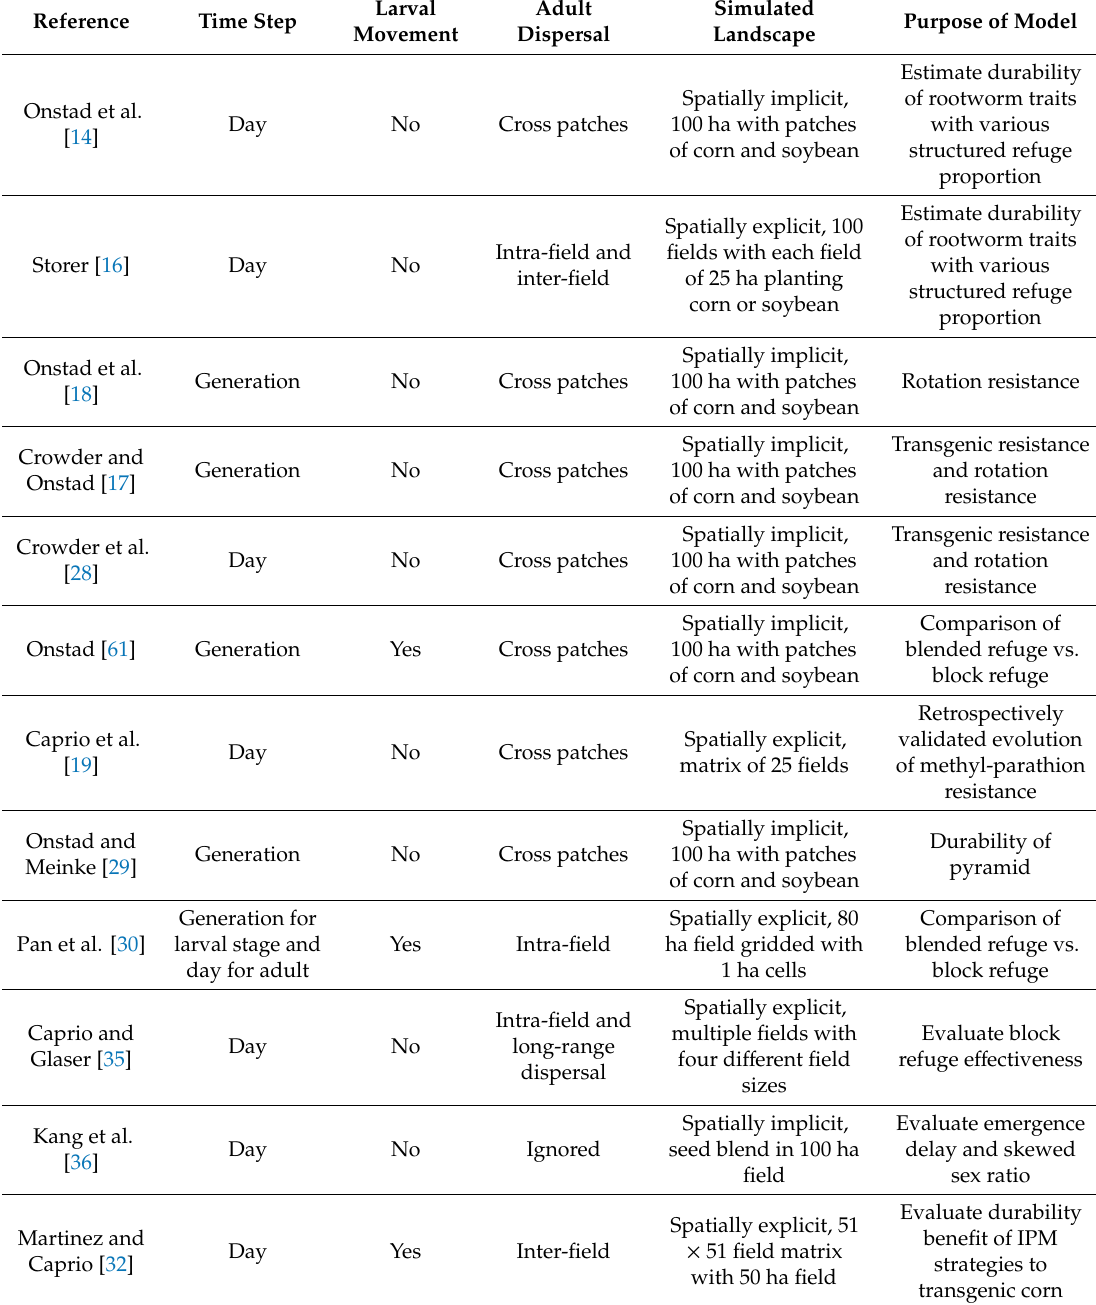
Table 1. Purpose of model relative to integrated pest management (IPM) determines the complexity of model